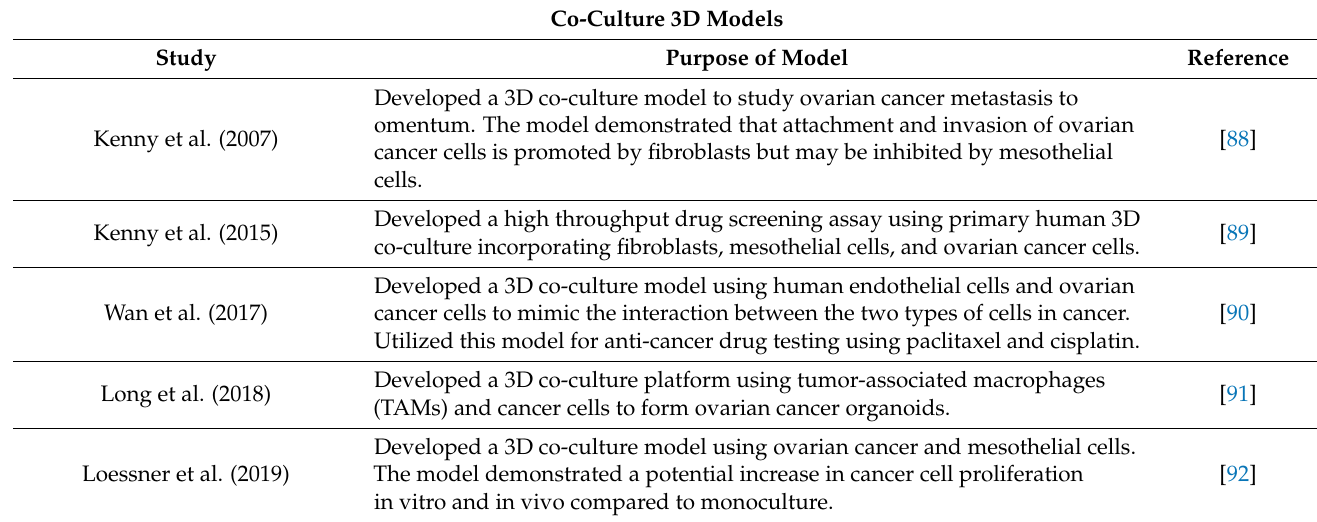
Table 6. Advanced 3D cell culture models developed in ovarian cancer.